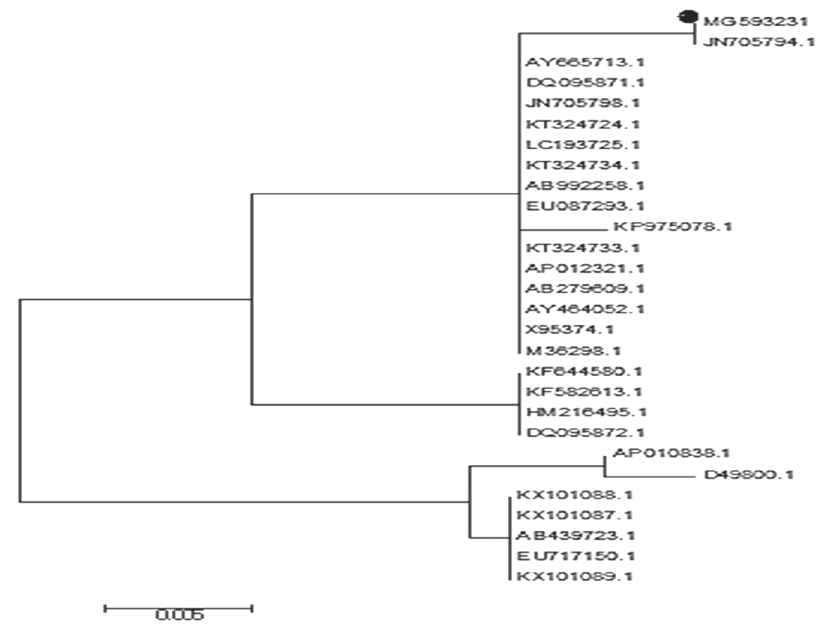
Figure 3. Phylogenetic tree construction of